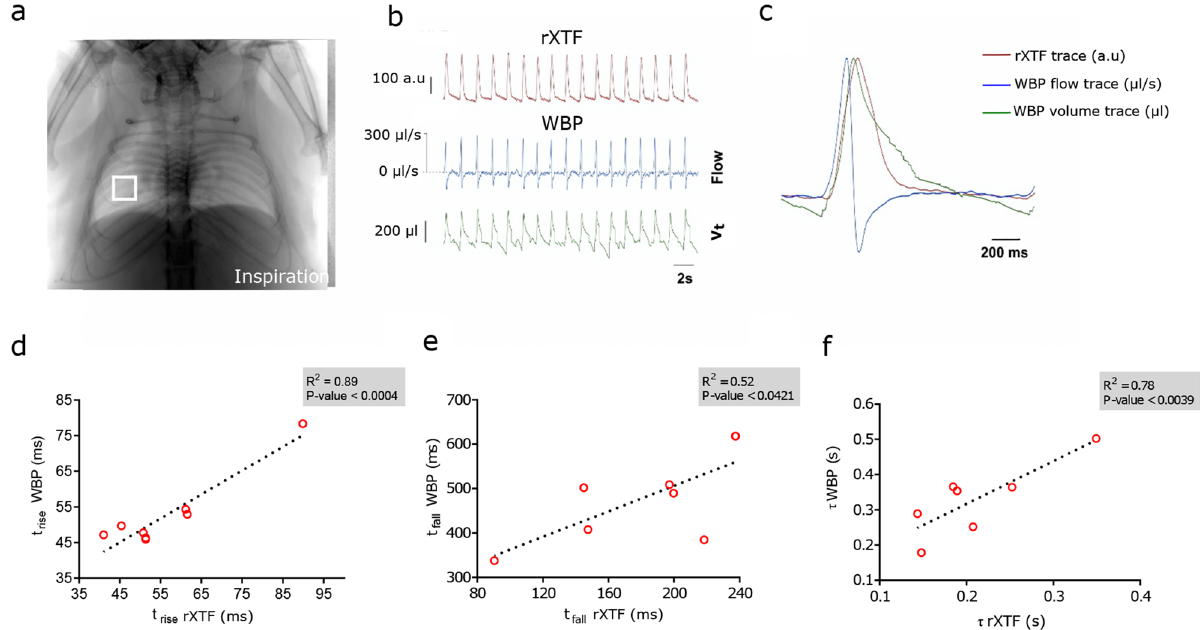
Figure 2. Comparison of traces from relative X-ray transmission function (rXTF) at lung region and WBP. ( a ) XLF-image in inspiration. The white box indicates the region of interest (ROI) that was used to measure changes in intensity of rXTF. ( b ) Data from rXTF and WBP. Red trace: rXTF at the ROI (arbitrary units). Blue trace: band pass filtered (0.5–20 Hz) flow trace (µl/s) from the WBP. Green trace: WBP Volume trace (V t , µl) derived from the integral of the flow (reset each cycle). ( c ) Averaged data from ( b ). ( d – f ) Correlation of the time course and signal derived from rXTF and WBP, ( d ) time rise (t rise ) of the signal (20–80%), ( e ) decay of the signals (t fall ) (20–80%) and ( f ) tau (τ) using a mono-exponential fit (peak to baseline, LabChart 8.0, ADInstruments). p values and respective coefficients of determination (R 2 ) from linear regression analysis are shown on the paired t-test, Fig. 2e) and τ 215.4 ± 65.4 ms for rXTF and 341.3 ± 92.6 ms for WBP (p < 0.0039, Fig. 2f). One factor that may account for the difference is the uncertainty regarding the position of the zero-flow point for the end of each respiratory cycle. Moreover, the slower flow for rXTF during expiration that accounts for this difference, might be a consequence of isoflurane-induced bronchoconstriction 29 . Micro-CT based volume measurements. We derived separate volumes ( V [ µ CT ] ) for the lung in inspira-